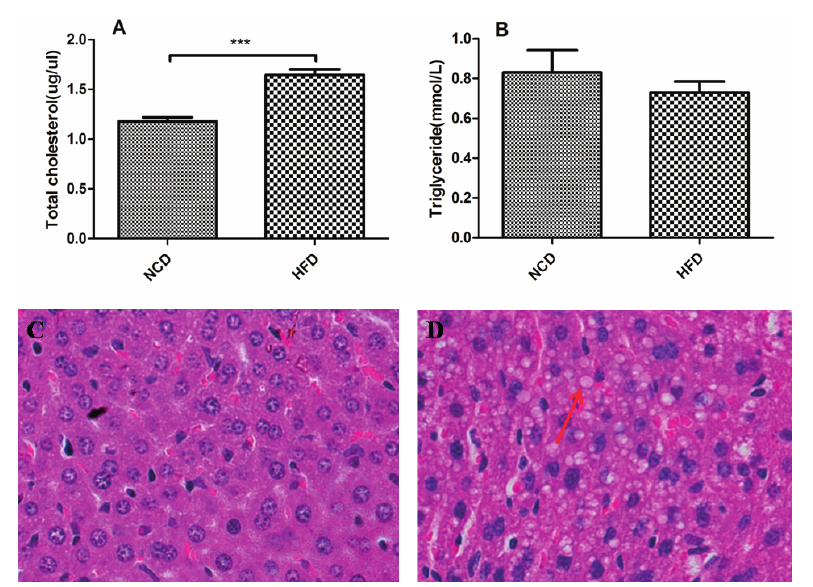
Figure 3. Lipid metabolism parameters of the offspring at weaning in the high-fat diet and normal chow diet groups. ( A ) Serum triacyglycerol and ( B ) total cholesterol; ( C ) Liver histology of haematoxylin and eosin staining in the offspring from the dams fed a normal chow diet had normal liver structure; ( D ) Lipid vacuoles (red arrow) of various sizes were observed within the hepatocytes of the offspring from the dams fed a high-fat diet. Original magnification, 40×. Data represented as the mean ± S.D. ( n =16, per group, 8 male and 8 female). *** p < 0.001 vs. the normal chow diet group. HFD, high-fat diet; NCD, normal chow